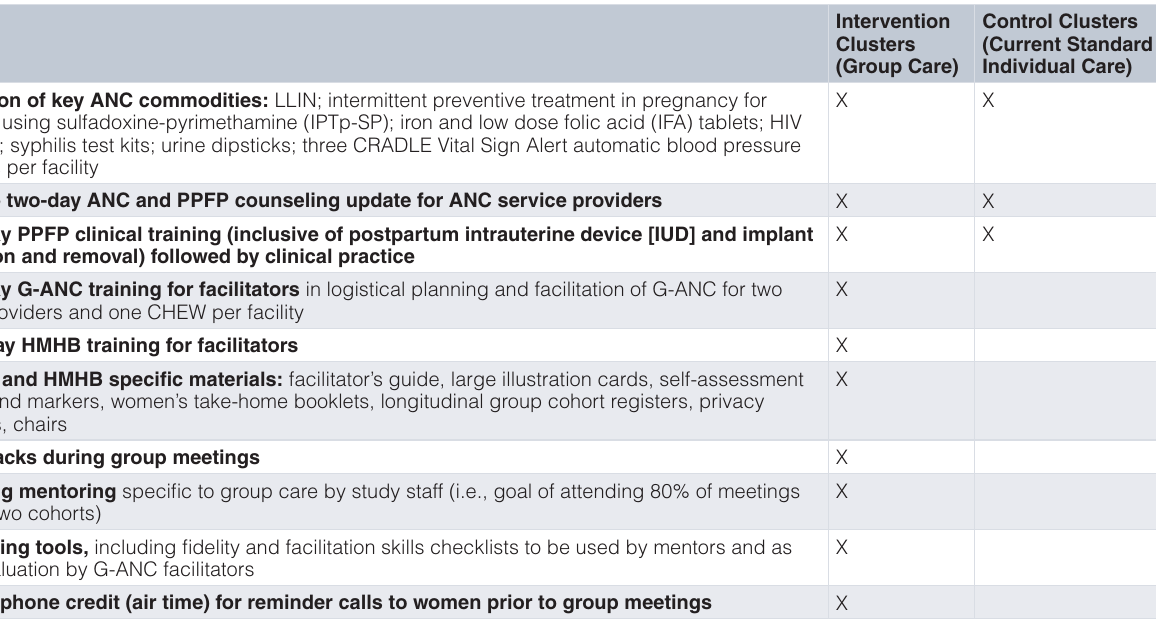
Control Clusters Clusters (Current Standard (Group Care) Individual